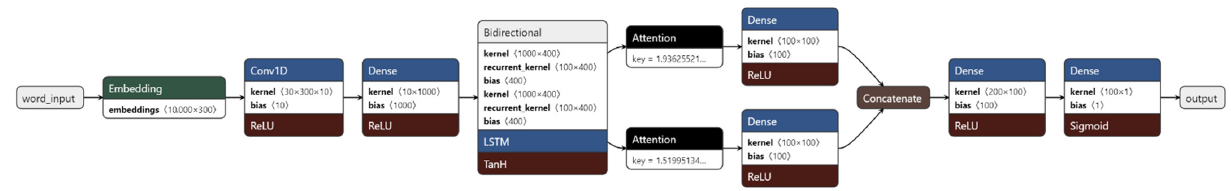
Figure 6. Implemented LSTM ‐ CNN.